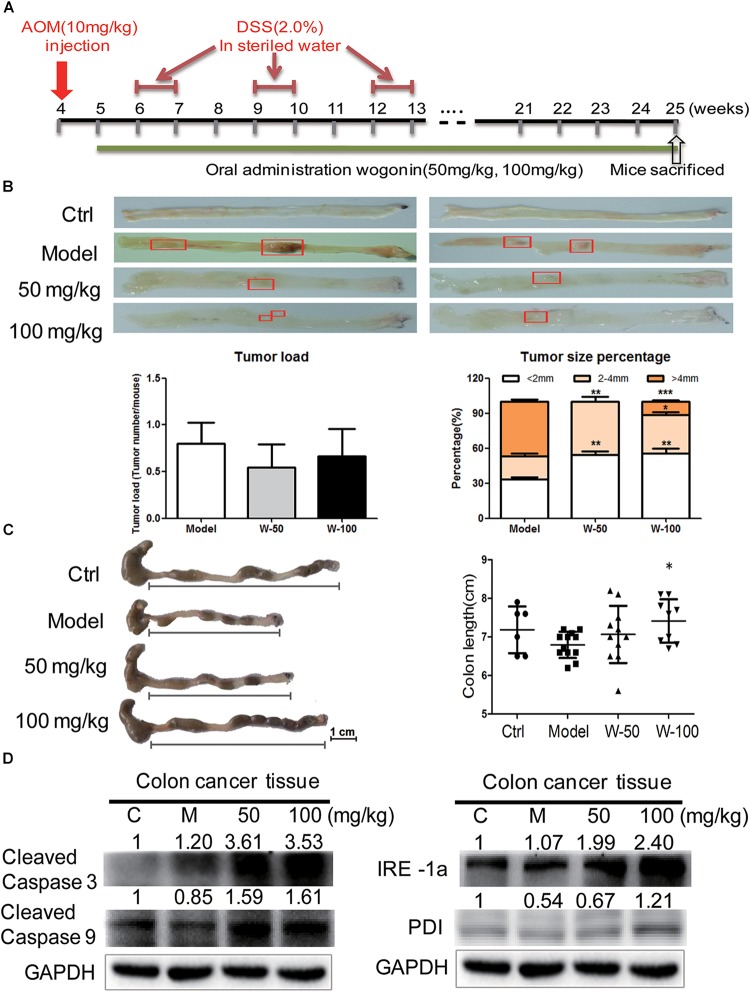
Wogonin inhibited tumor carcinogenesis in AOM/DSS induced CRC. (A) Schematic diagram of AOM/DSS-induced colitis associated colon cancer model (n = 15 for each group). (B) The cutaway view of mice colon tissue and the number of tumor load at the endpoint of experiment, tumor size of colonic neoplasms in each group. (C) The colon length changes were measured by using a scaled ruler in each group. (D) Apoptotic and ER-stress related proteins expression after wogonin treatment (50 and 100 mg/kg) for 21 weeks in mice were determined by western blot. GAPDH was used as an equal loading control, significant difference versus control group, ∗P < 0.05; ∗∗P < 0.01; ∗∗∗P < 0.001.